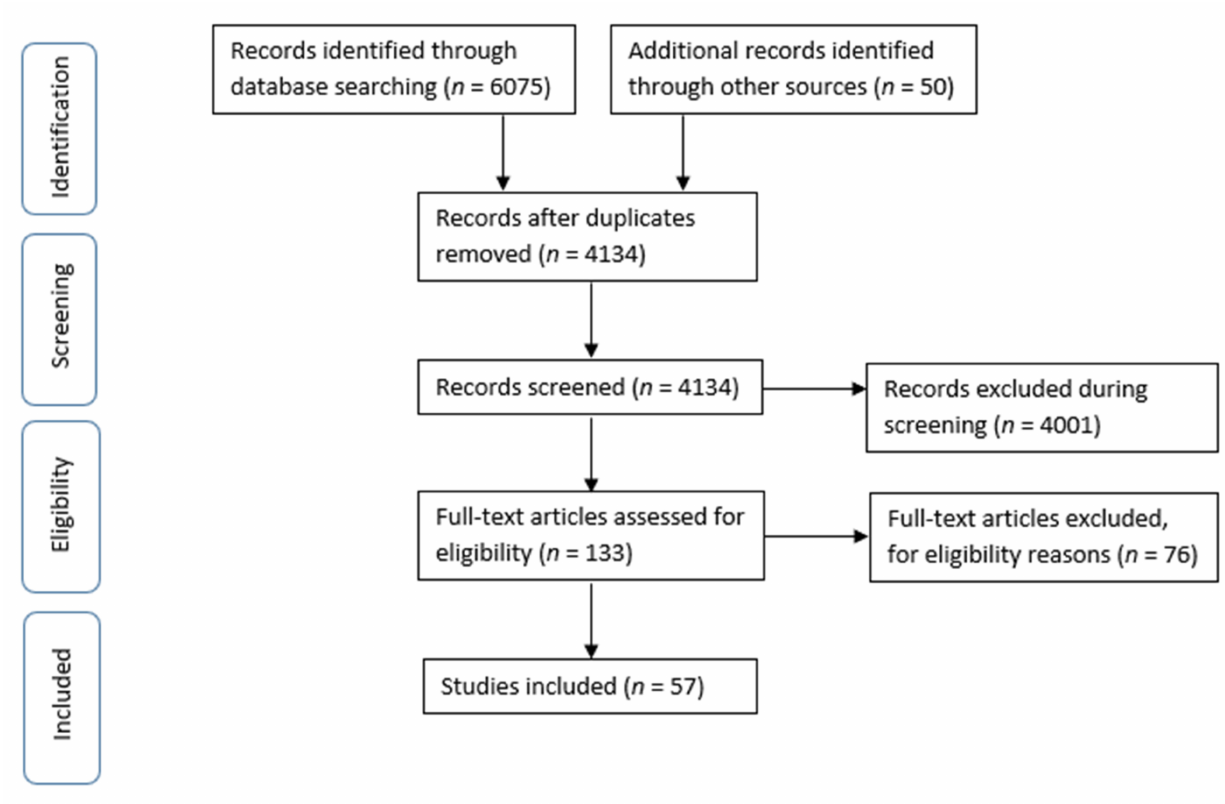
Figure 1. PRISMA Flow